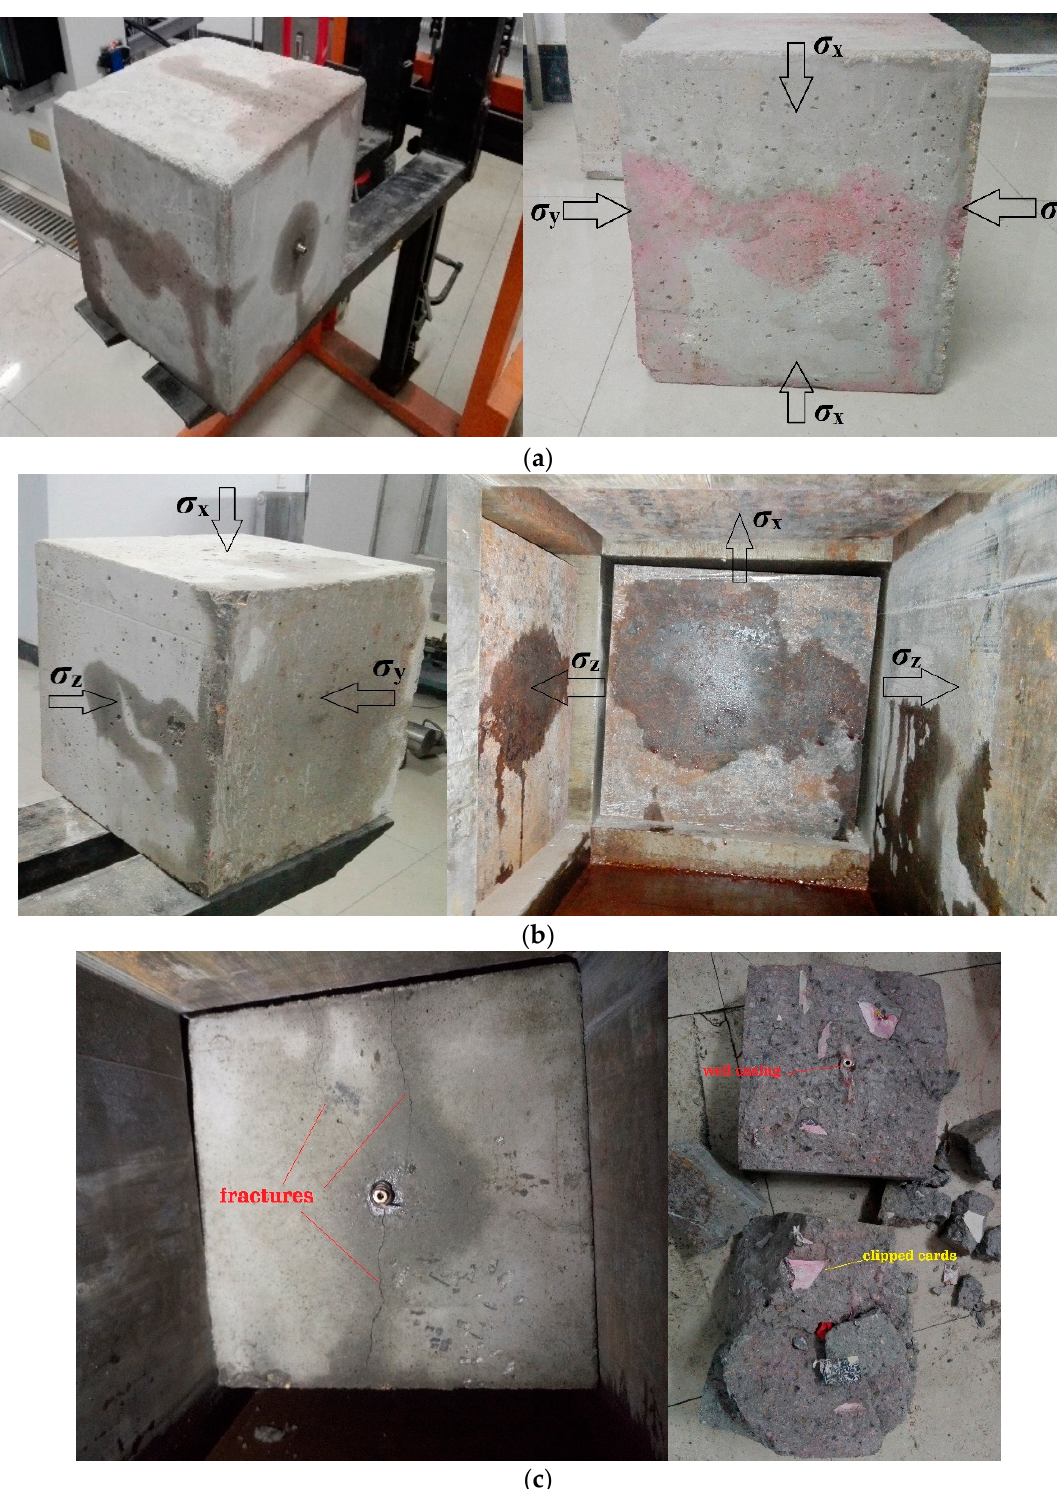
Figure 10. Fracture morphology of H1 ( a ), H2 ( b ), and F1 ( c ).